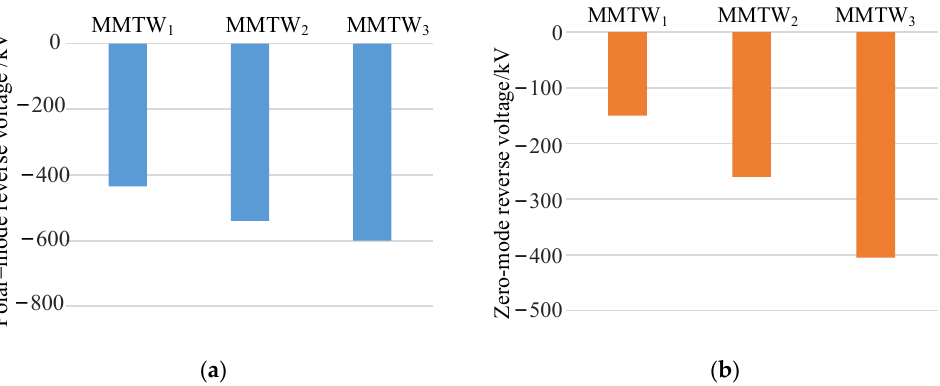
Figure 10. Wavelet transform results of maximum waveform in the positive pole to ground metal short ‐ circuit fault signal. ( a ) Polar ‐ mode reverse ‐ voltage traveling wavelet mode maximum waveform; ( b ) Zero ‐ mode reverse ‐ voltage traveling wavelet mode extreme waveform. Figure 11a illustrates that when the negative ‐ fault traveling wave reaches R1, the po ‐ lar ‐ mode voltage of the DC line is similar to the positive fault. Both the polar ‐ mode volt ‐ age and the zero ‐ mode voltage of the DC line suddenly drop, and then slowly rise, with a maximum difference of about 800 kV. The zero ‐ mode voltage under a negative fault is the opposite of that under a positive fault which will suddenly increase and then slowly decrease, with a maximum increase of about 800 kV. The polar ‐ mode reverse ‐ voltage trav ‐ eling wave decreases to − 480 kV and remains basically unchanged, while the zero ‐ mode reverse ‐ voltage traveling wave increases to 500 kV and slowly decreases.